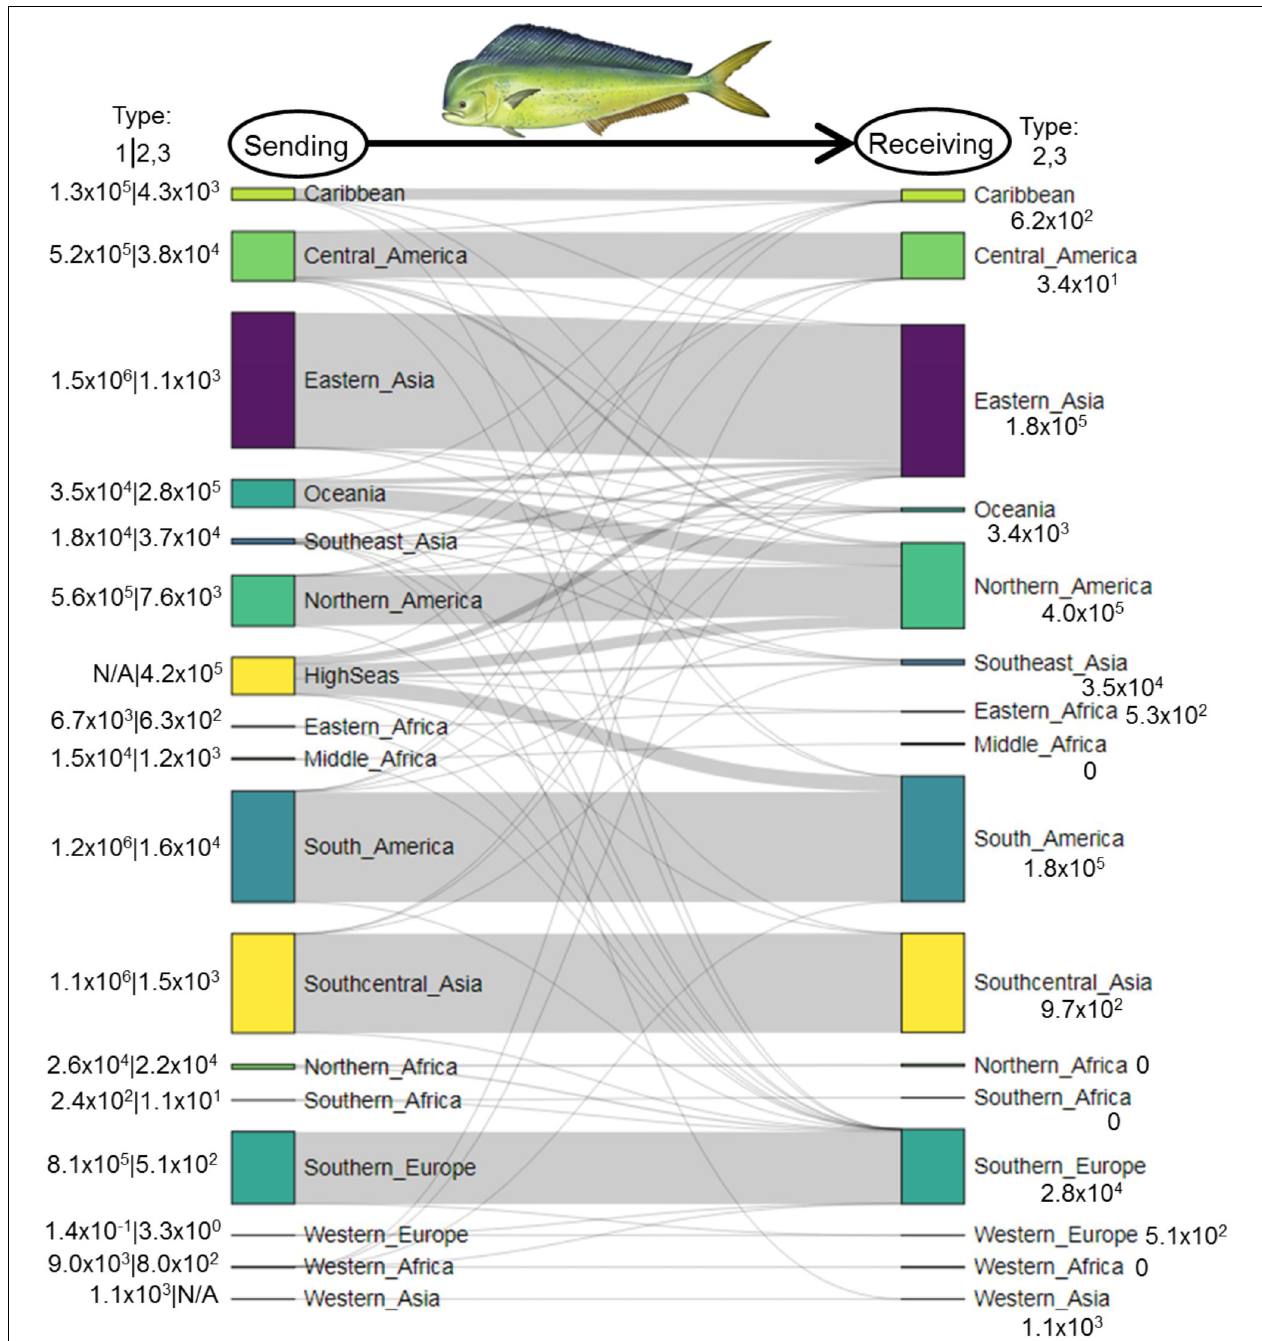
FIGURE 3 | Sankey diagram depicting flows of mahi-mahi (metric tons) within and between world regions from sending systems (left) to receiving systems (right) in 1950–2014. In the left margin, numbers to the left of the divider represent Type 1 fishing—total catches by each region within its own exclusive economic zones. Numbers to the right of the divider represent Type 2/3 fishing—total catches in each region by nations located outside the region. Numbers in the right margin are Type 2/3 catches by each region in other regions.